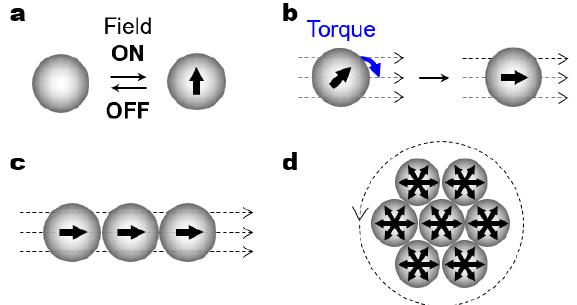
Figure 2. Basic mechanisms of field-driven particle behavior. ( a ) Particle polarization in response to the application of an external (magnetic or electric) field. ( b ) Field-driven torque aligning the induced dipole of the particle along the field direction. The blue arrow represents the alignment torque exerted by the external field. ( c ) The assembly of polarized particles into a linear chain as a result of anisotropic dipolar interaction. ( d ) The assembly of polarized particles into a hexagonal structure as a result of time-averaged isotropic dipolar interaction. The arrows inside the particles indicate the direction of an induced dipole. The dotted arrows outside the particles indicate the direction of external